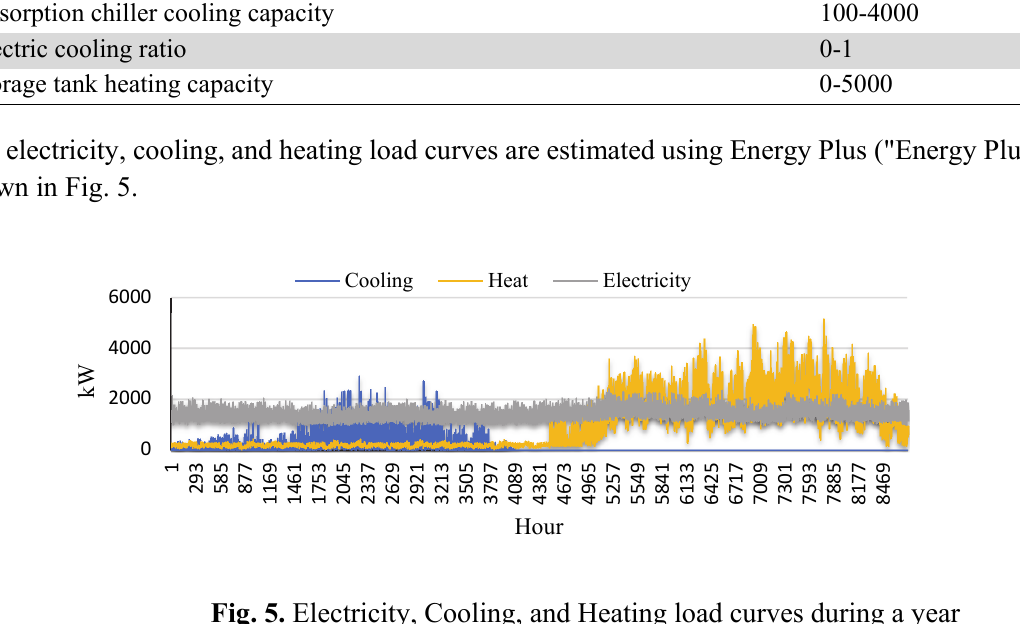
Fig. 5. Electricity, Cooling, and Heating load curves during a year